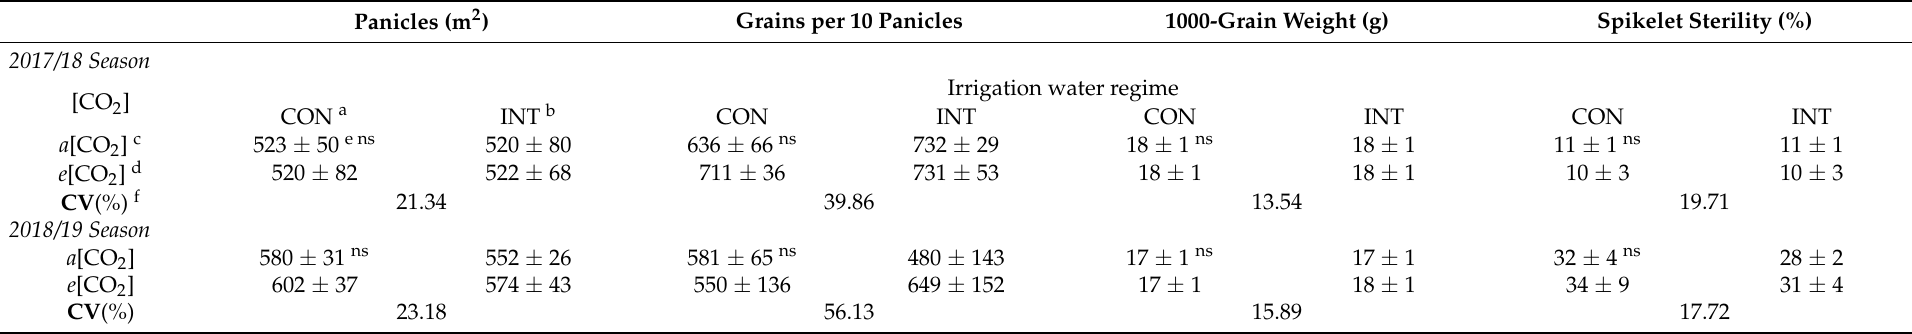
Table 1. Effects of CO 2 concentrations (400 µ mol mol − 1 vs. 700 µ mol mol − 1 ) and water regimes (continuous vs. intermittent) on rice panicle number m 2 , number of grains per 10 panicles, weight per thousand grains, and spikelet sterility for two growing